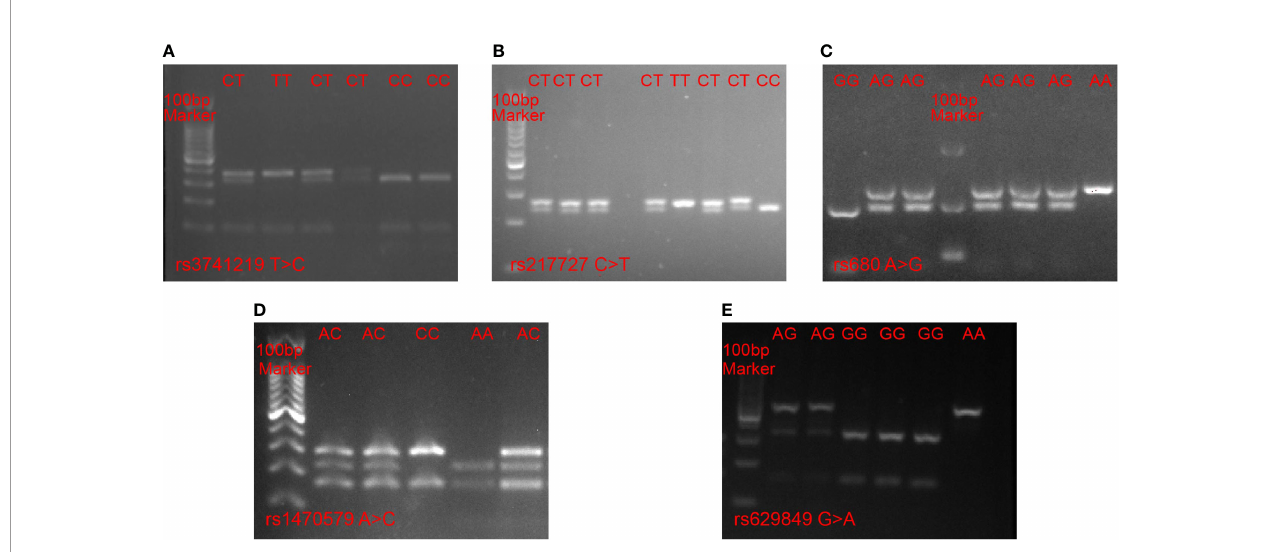
FIGURE 1 | PCR-RFLP analysis of fi ve SNPs. (A) rs3741219 T > C in the H19 gene, (B) rs217727 C > T in H19 gene, (C) rs680 A > G in IGF2 gene, (D) rs1470579 A > C in IGF2BP2 gene, (E) rs629849 G > A in IGF2R